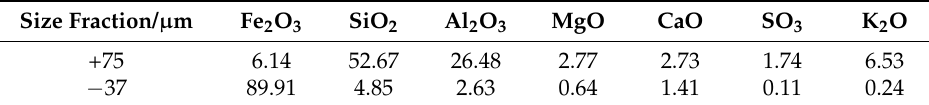
Table 5. Results of quantitative EDS analysis of the calcine/(mass fraction, %).